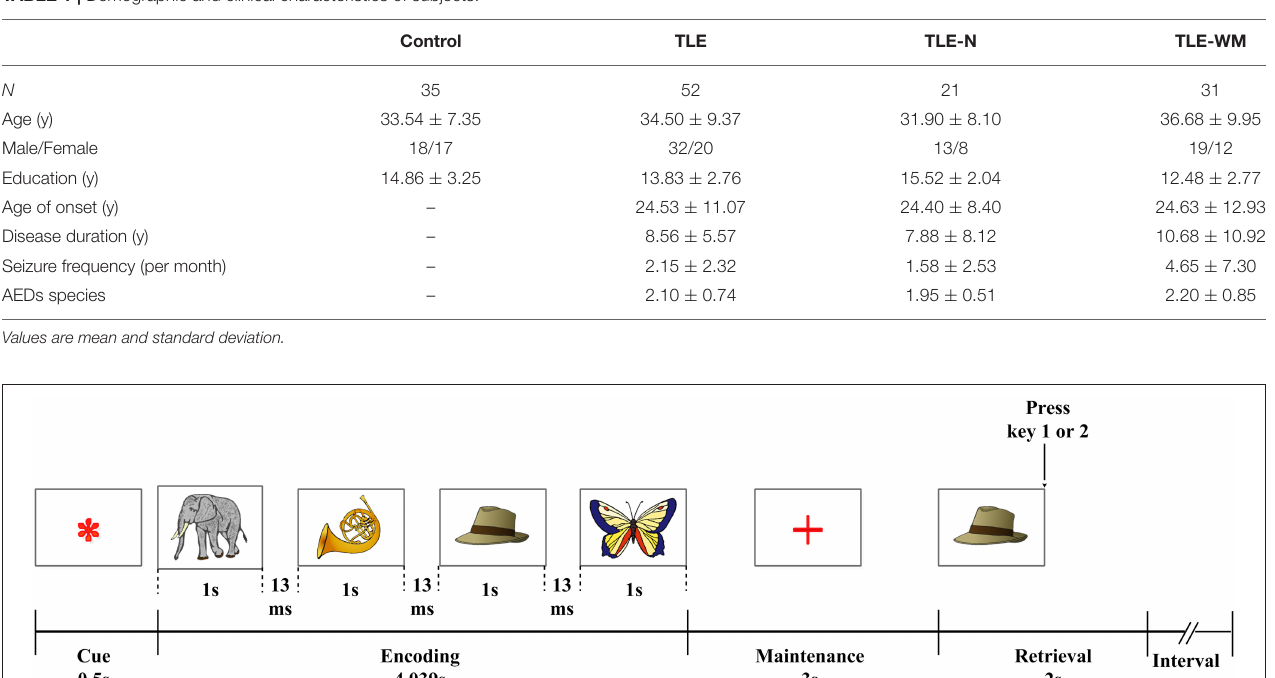
TABLE 1 | Demographic and clinical characteristics of subjects.